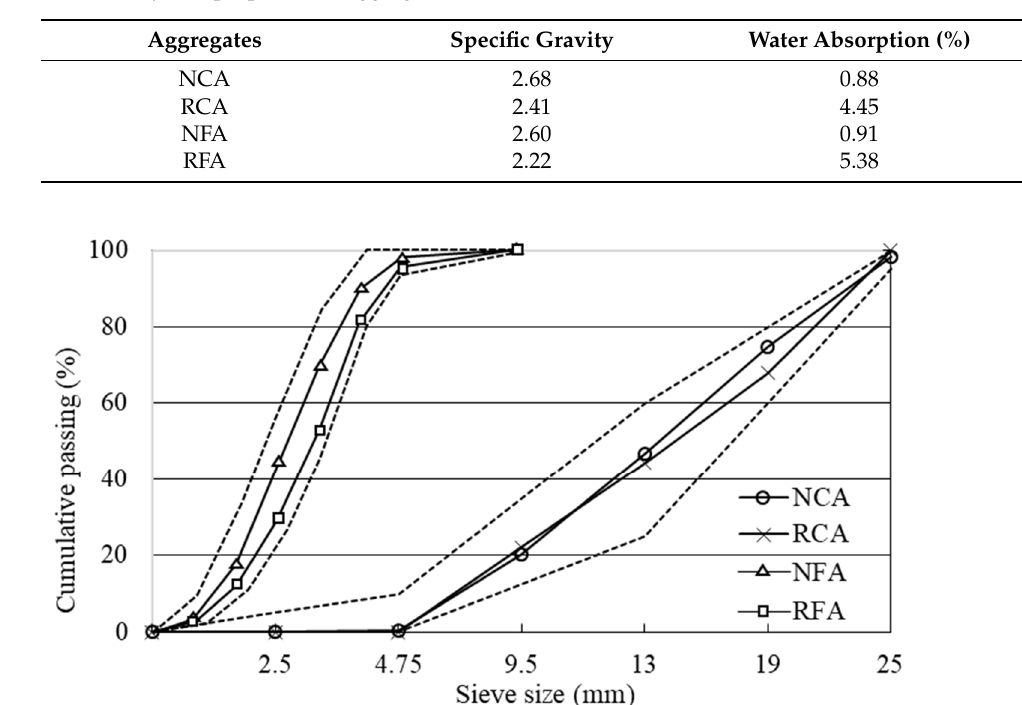
Table 2. Physical properties of aggregates.